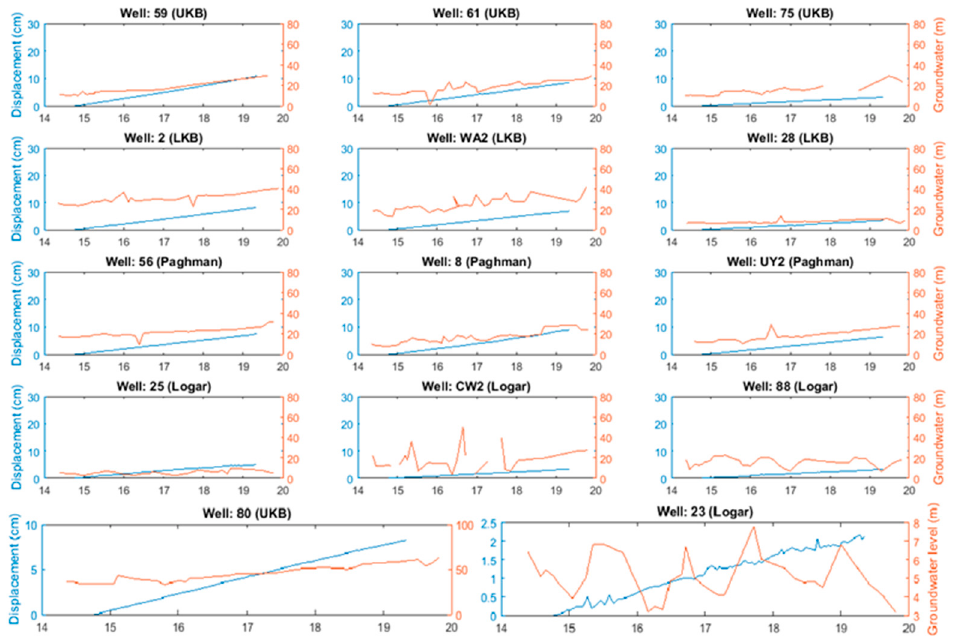
Figure 6. Comparisons of InSAR-derived displacement time-series (blue lines) and groundwater level changes (yellow lines) at fourteen wells across the network. Location of the wells are shown in Figure 5a.